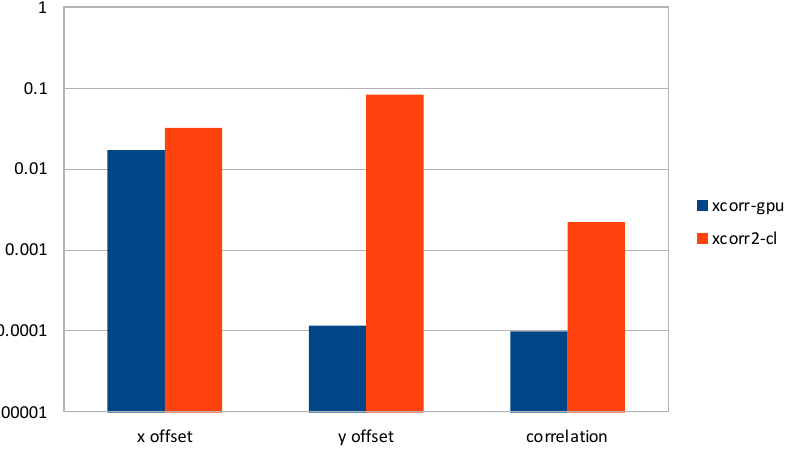
Figure 7. Comparison of average η ∞ on selected datasets for xcorr-gpu and xcorr2-cl , in logarith- mic scale.